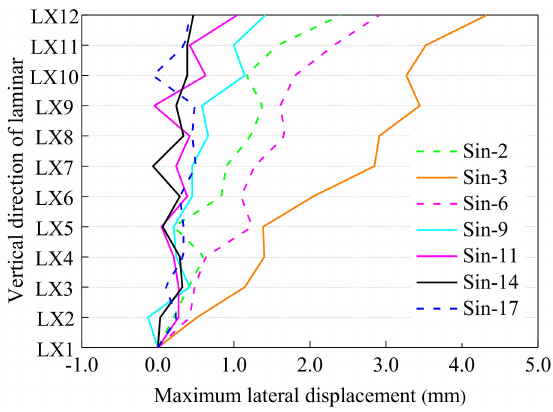
Figure 16. Maximum lateral displacement of the laminar box along